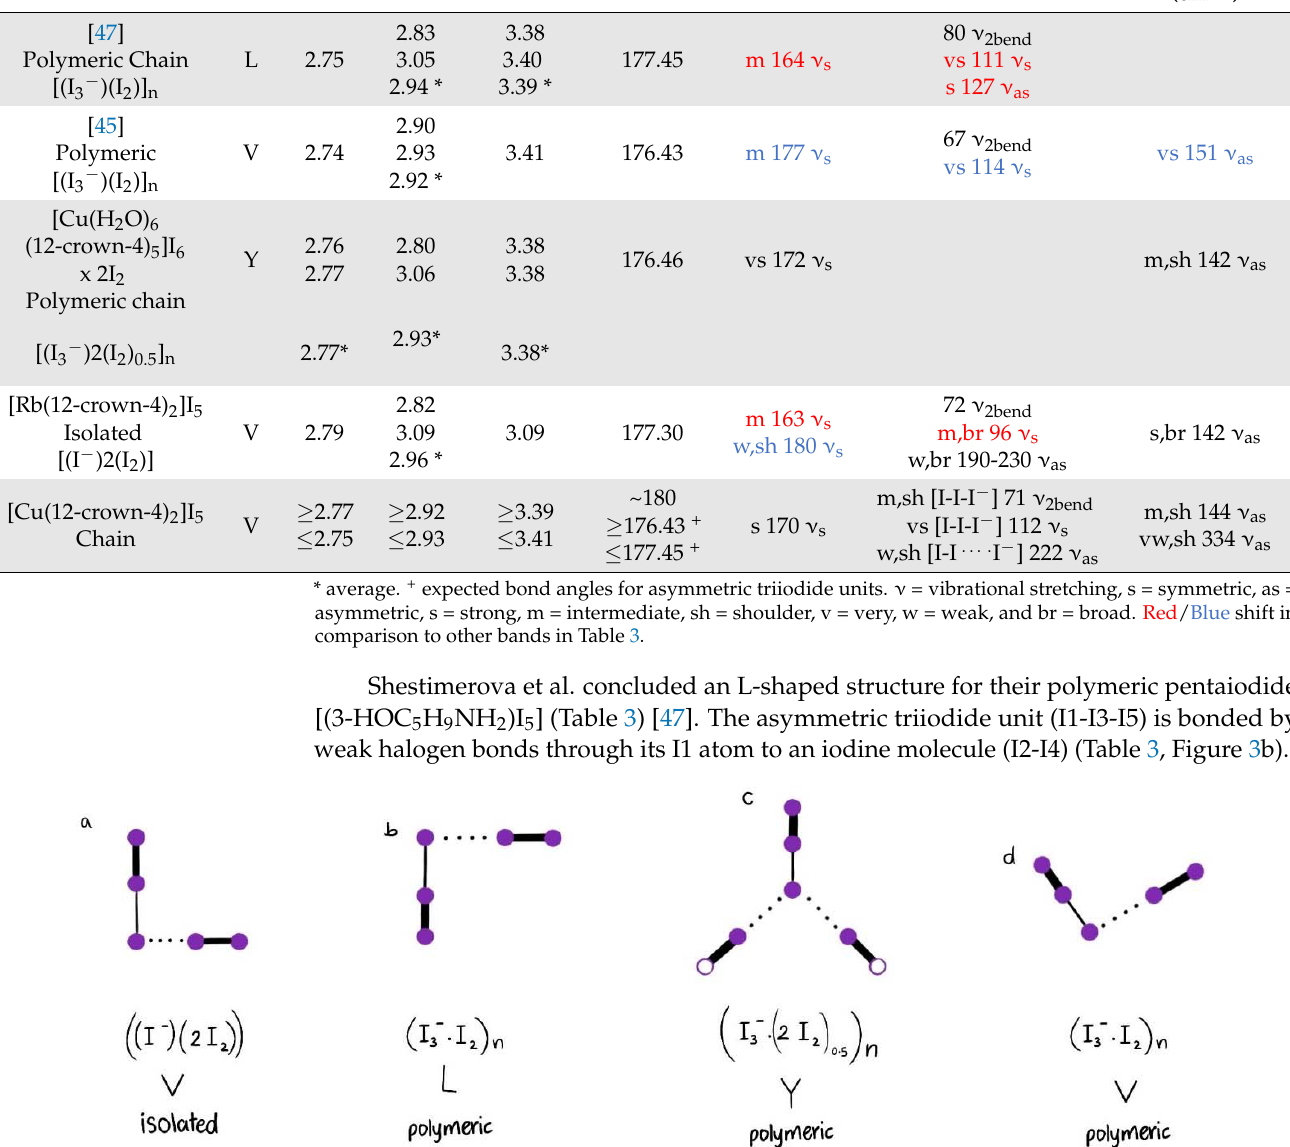
Table 3. Comparative study with [Cu(12-crown-4) 2 ]I 5 , [Cu(H 2 O) 6 (12-crown-4) 5 ]I 6 x 2I 2 (2) [50], and previous investigations [45,47,49] (cm − 1 ).